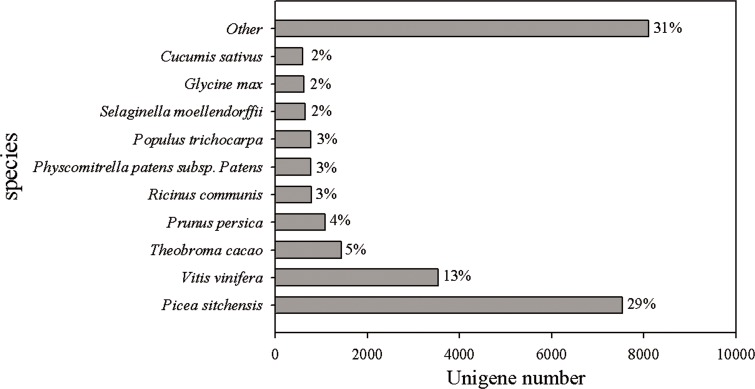
Species distribution of the top BLAST hits in Nr dababase.Top BLASTX results for 26,305 unigenes were calculated. Species with proportions of more than 1% are shown.